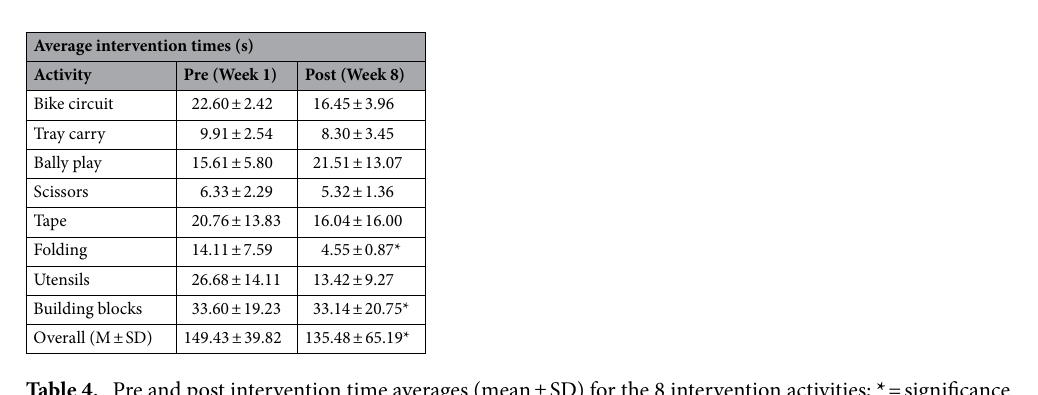
Table 4. Pre and post intervention time averages (mean ± SD) for the 8 intervention activities; * = significance ( p <